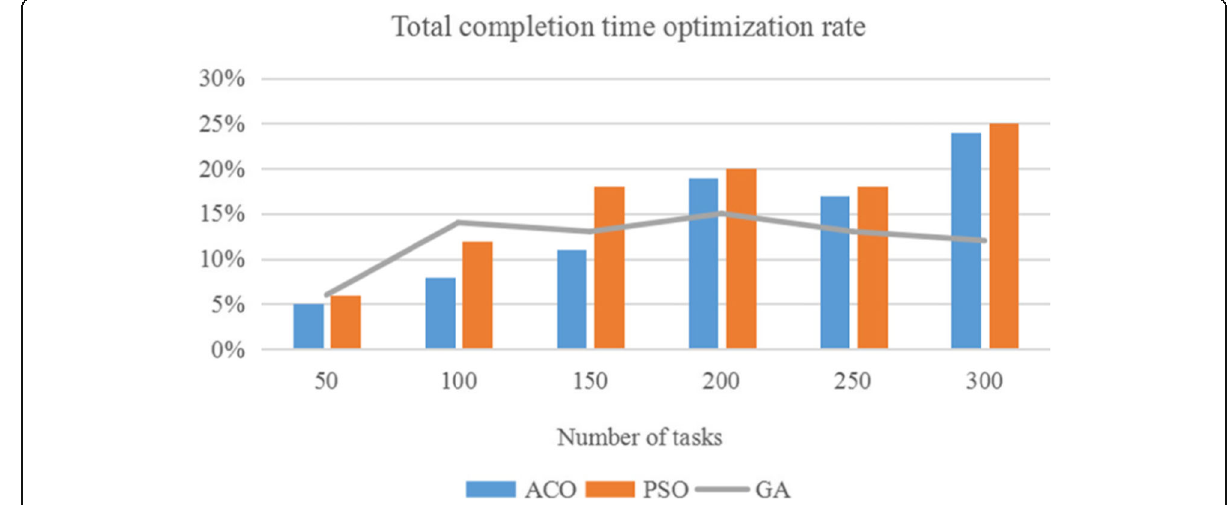
Fig. 7 Optimization rate of overall completion